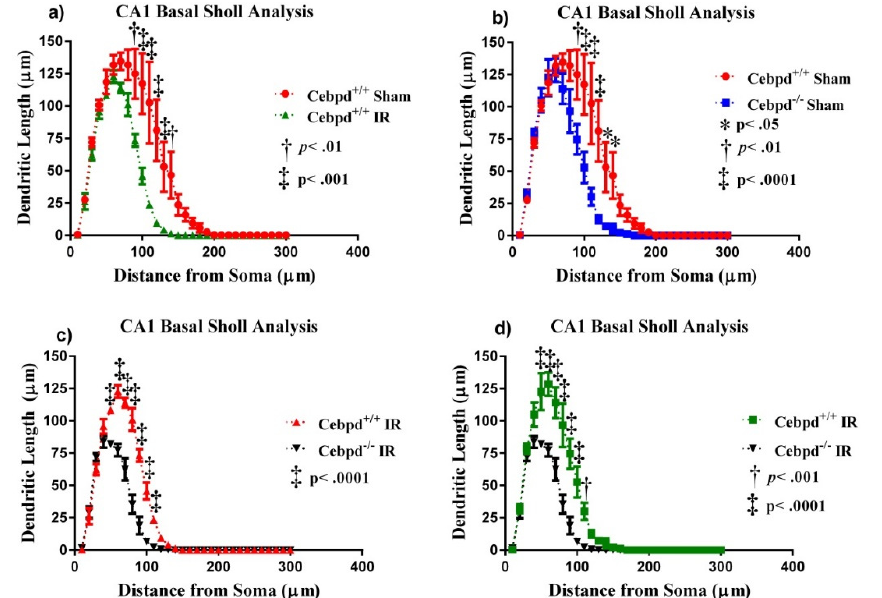
Figure 5. Sholl analyses of neurons in the CA1 basal. ( A ) Dendritic length, measured by Sholl analysis radiation decreased length at 90–140 µ m from the soma when Cebpd +/+ -sham were compared to Cebpd +/+ -IR. ( B ) There was a decrease in length at 90–140 µ m from the soma when Cebpd +/+ -sham were compared to Cebpd − / − -sham. ( C ) Radiation decreased length at 50–110 µ m from the soma when Cebpd +/+ -IR were compared to Cebpd − / − -IR. ( D ) Treatment greatly decreased length at 50–110 µ m from the soma when Cebpd − / − -sham were compared to Cebpd − / − -IR. Average ± SEM ( n = 5).